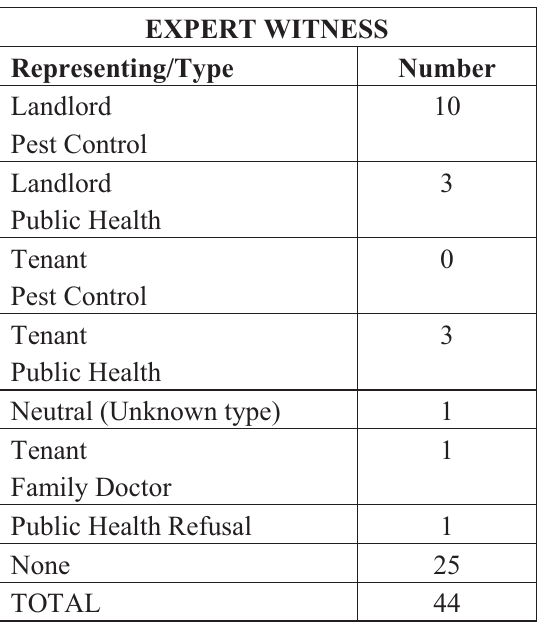
Table 2. Expert Witness Type and